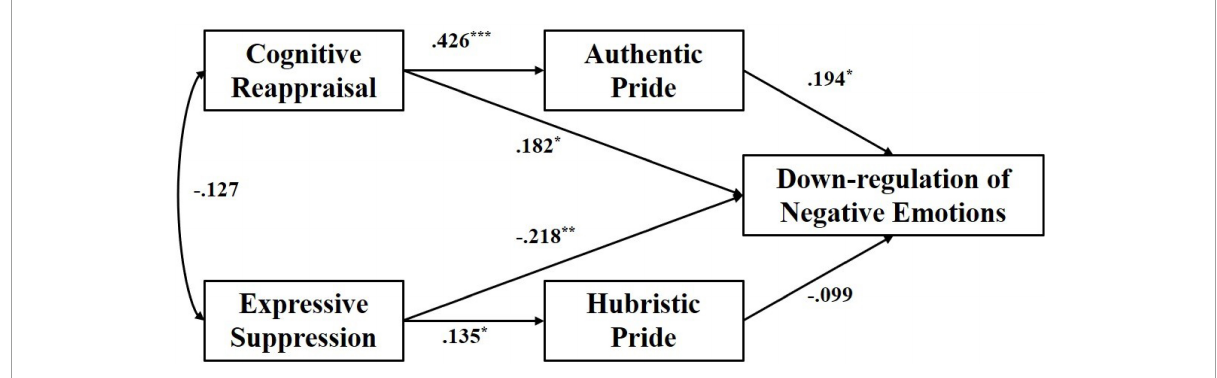
FIGURE2 Mediating effect model of two faces of pride (AP; HP) between two kinds of emotional regulation strategies and down-regulation of negative emotions. *** p < 0.001, ** p < 0.01, * p < 0.05.